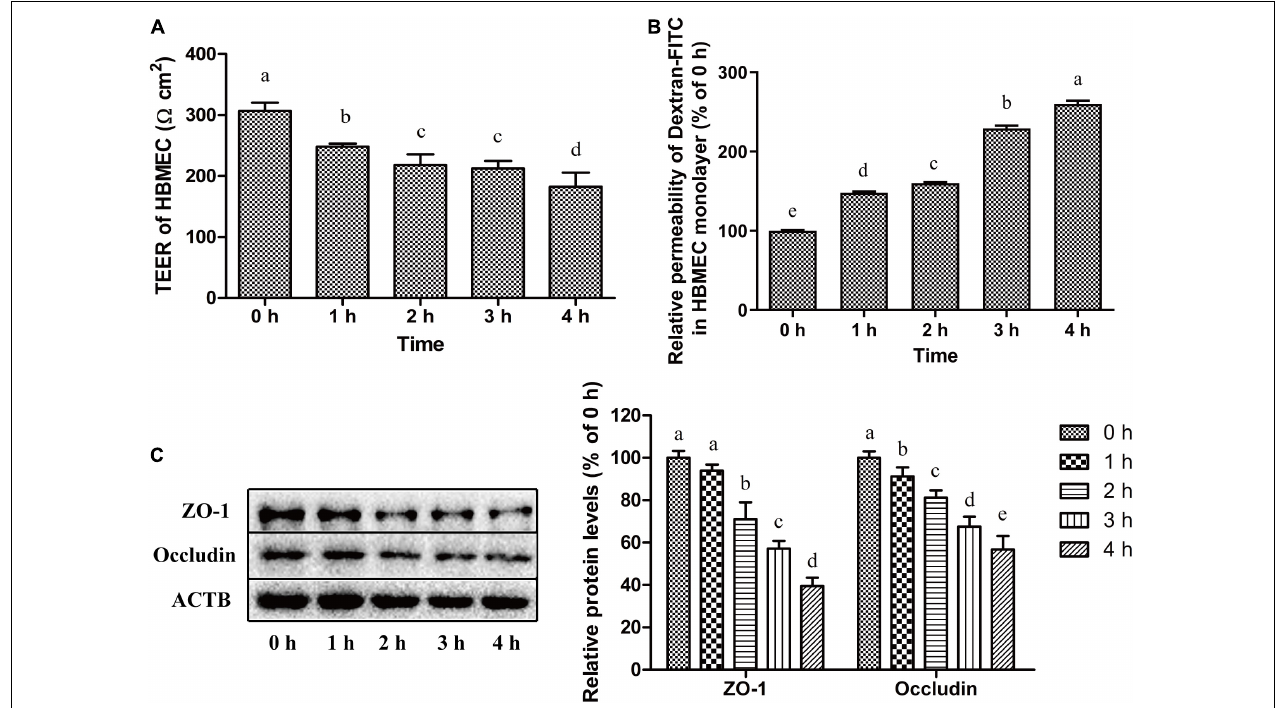
FIGURE 5 | C. sakazakii disrupted tight junction of HBMEC monolayers. (A) The TEER of HBMEC monolayer after C. sakazakii infection for 0, 1, 2, 3, and 4 h. (B) Dextran-FITC (4 kDa) permeability in HBMEC monolayer infected with C. sakazakii . (C) The expression of tight junction-related proteins ZO-1 and Occludin in C. sakazakii -infected HBMEC were detected by Western Blot. Error bars represent the standard deviation ( n = 3). Mean values with different lower-case letters are statistically different from one another ( P <